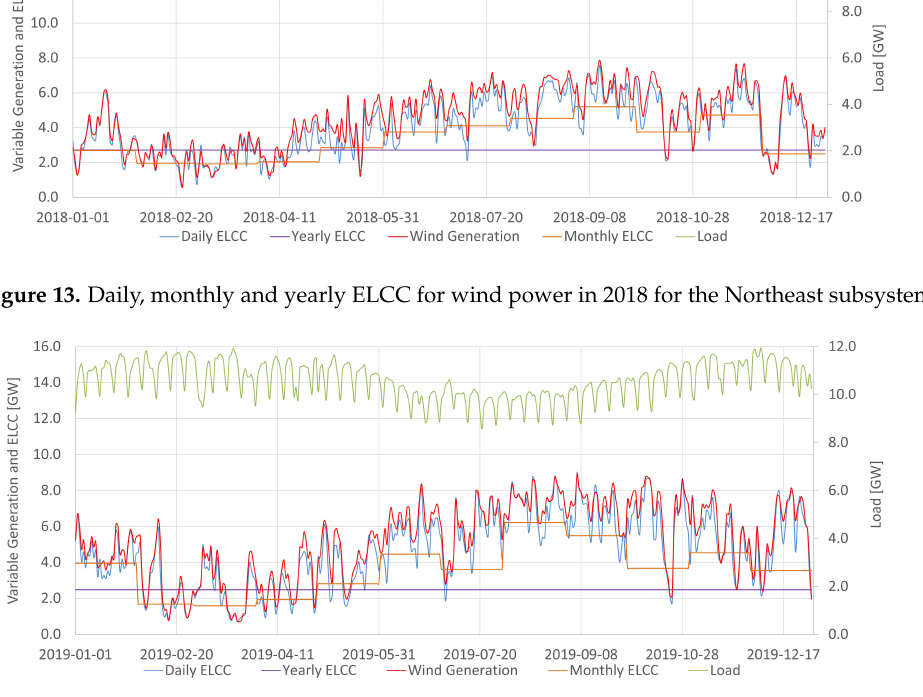
Figure 14. Daily, monthly and yearly ELCC for wind power in 2019 for the Northeast